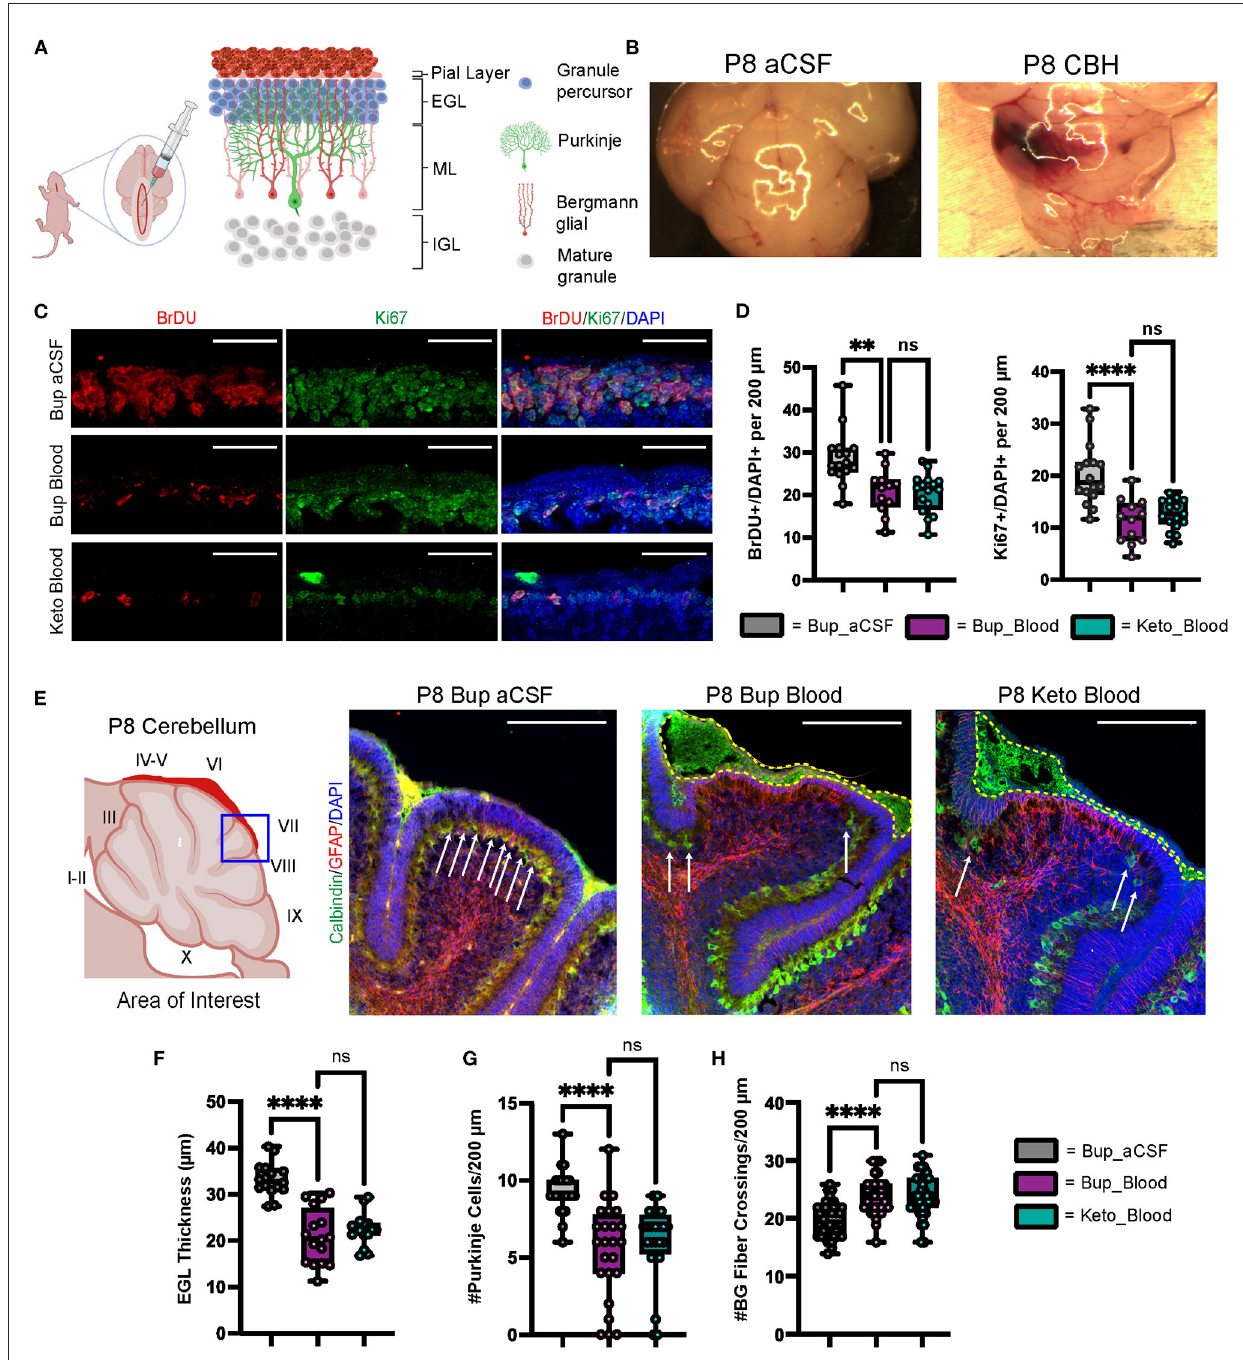
FIGURE1 CHI results in decreased BrDU and Ki67 labeling indices, thinning of the EGL, decreased PC density, and increased BG fiber crossings at P8. (A) Schematic illustrating isolated posterior fossa hemorrhage model with typical P6 cerebellar architecture. (B) Representative comparative images of gross findings between aCSF and CHI groups; note large hematoma formation overlying left cerebellar hemisphere in the CHI specimen. (C) Representative confocal images at 40X of BrDU and Ki67 staining within the EGL. Only cells within the EGL were included in analysis. Scale bars are 25 µ m. (D) Quantification of labeling indices for BrDU (left) and Ki67 (right); data obtained from 200 µ m segment from lobule VI and VII ( N = 2, n = 12 for Bup_Blood; N = 3, n = 16 for Bup_aCSF and Keto_Blood). (E) Representative confocal images at 20X magnification of lobule VII demonstrating differences in local findings including presence of large RBC collections (yellow dashed outline), PC density (white arrows), thickness of EGL, and architecture of BG fibers. Scale bars are 100 µ m. (F) Quantification of EGL thickness for all treatment groups ( N = 4, n = 16). (G) Quantification of PC density in lobule VI and VII for all treatment groups ( N = 3, n = 24). (H ) Quantification of BG fiber crossings in lobule I, VII-IX for all treatment groups ( N = 3, n = 27). Significance defined as p < 0.05 by one-way ANOVA with Tukey post-test. Data are presented as SEM with minimum and maximum values. N = number of animals per group included for analysis; n = number of section segments per group included for analysis. ** p -value ≤ 0.01; **** p -value ≤